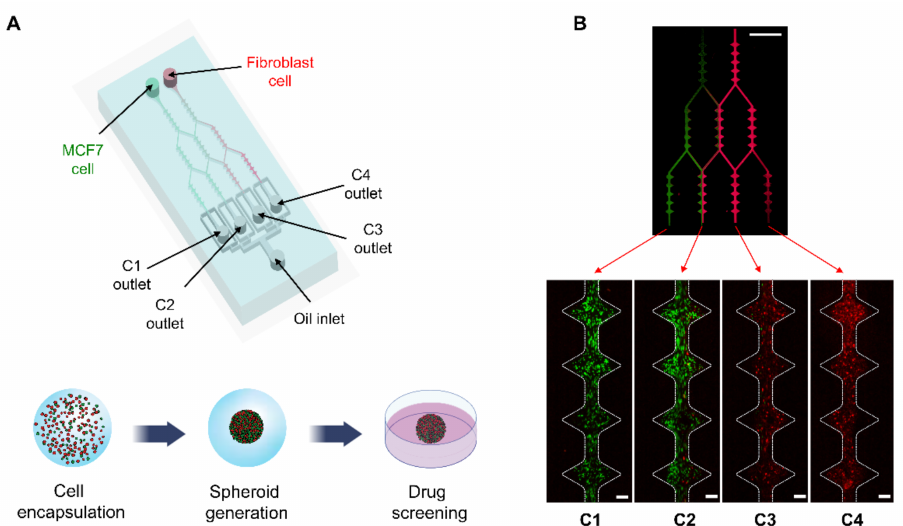
Figure 1. Experiment setup of microfluidic gradient droplet device for gradient-sized tumor spheroid generation. ( A ) Schematic illustration of gradient generation part and droplet generation part. Schematic 3D co-culture process of MCF-7 cells and fibroblasts. ( B ) Fluorescent image of gradient generation